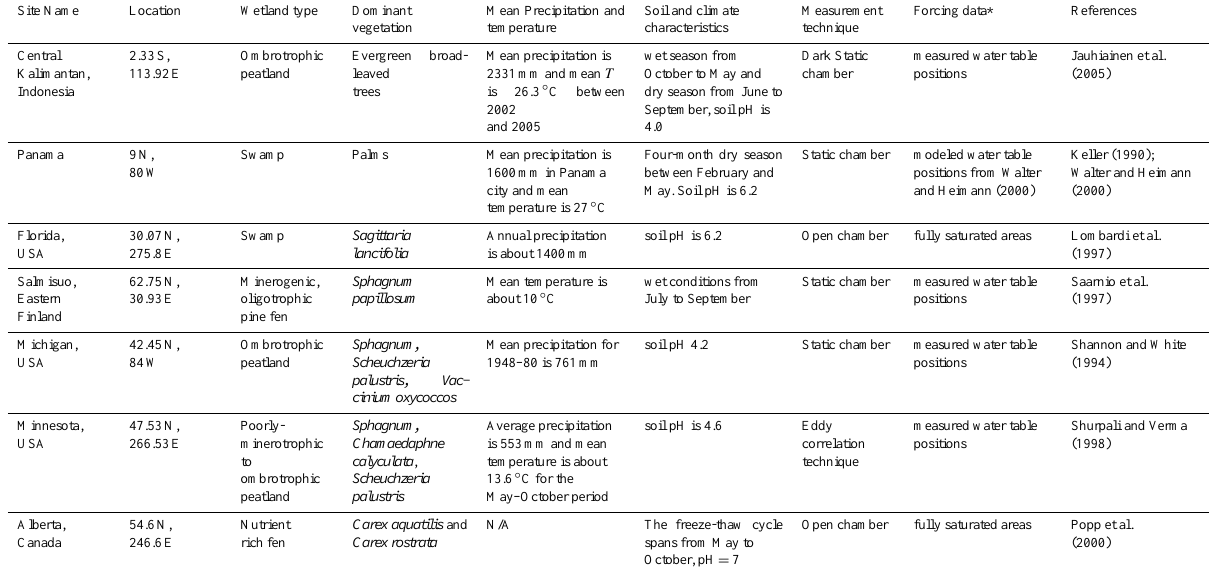
Table 2. Descriptions of wetland sites used in this study.